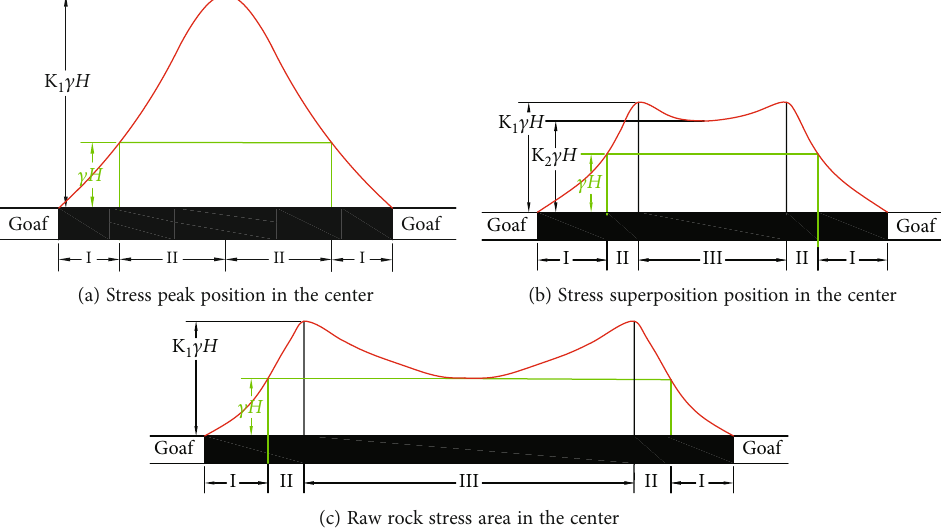
Figure 1: Abutment pressure distribution of coal pillars with di ff erent widths.